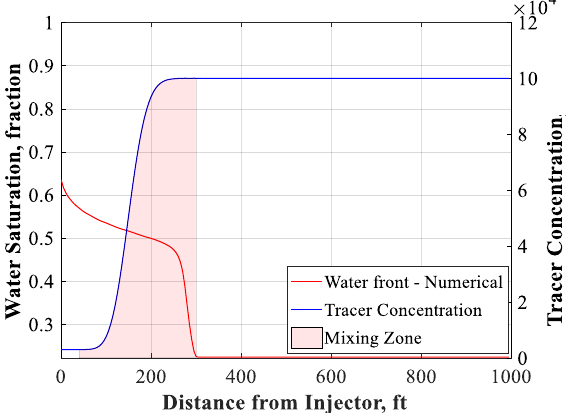
Figure A2. The location of the mixing zone within the leading waterfront after 462 days, illustrating the dilution curve of the tracer concentration when the injected water has significantly lower tracer concentration of 3000 compared to 100,000 of formation water.